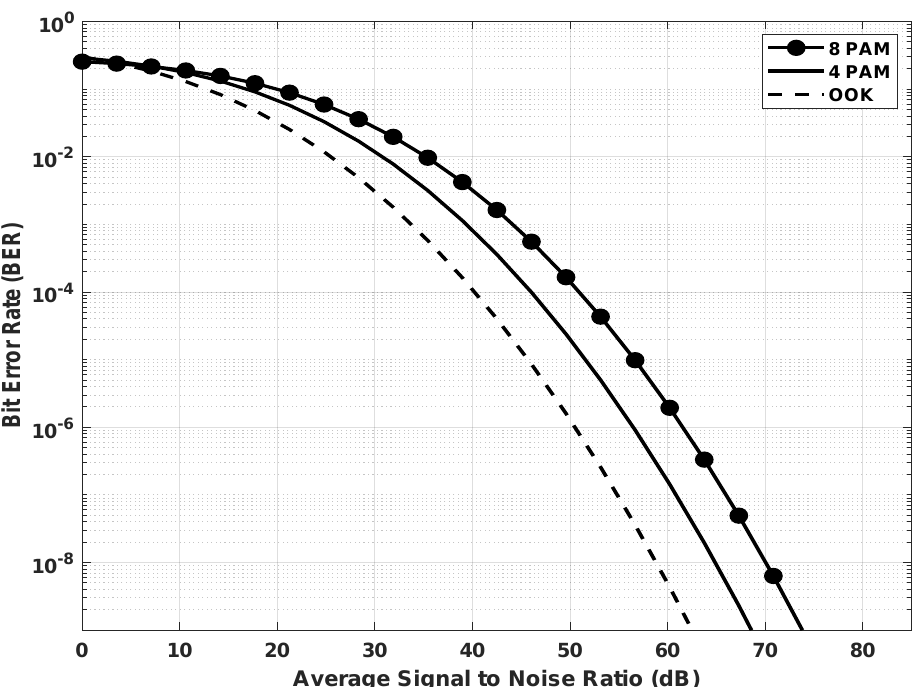
Figure 8. BER Performance for the Proposed System using Different Modulation Order for M-ary PAM in Winter, Modeled using the LN Channel, for 1 km.